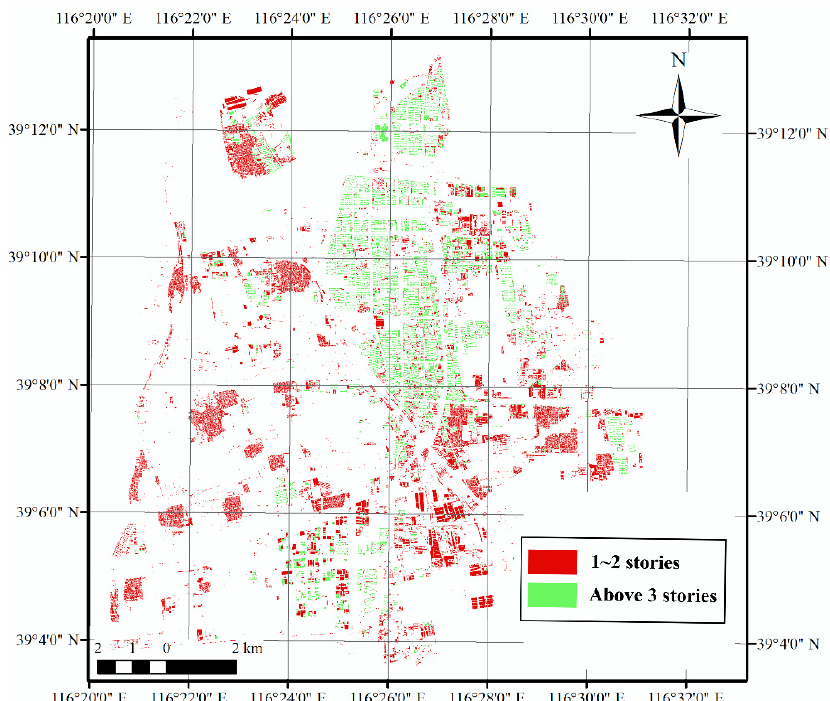
Figure 20. Building distribution with different story numbers.